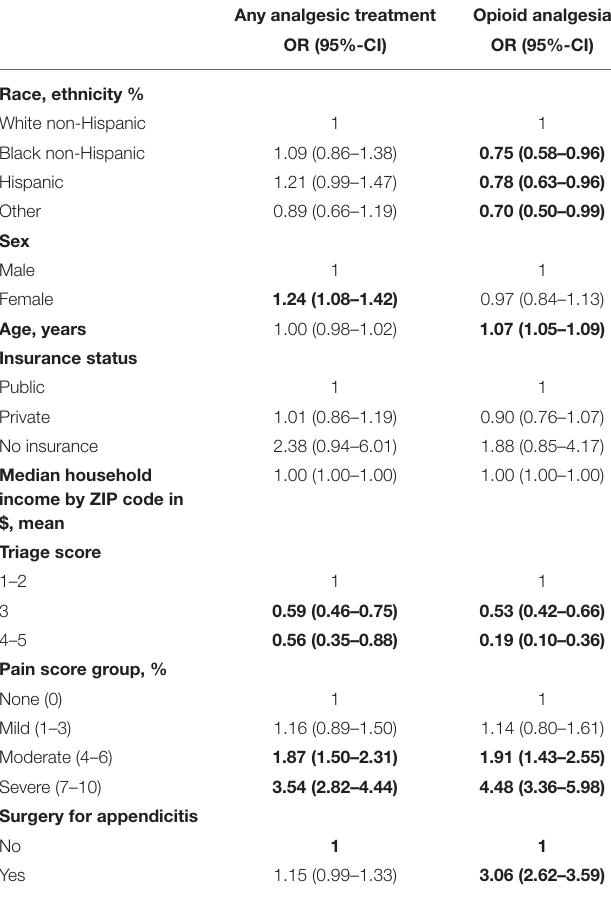
TABLE 5 | Factors associated with the administration of any analgesic treatment and opioid analgesia for children visiting the emergency department with suspected